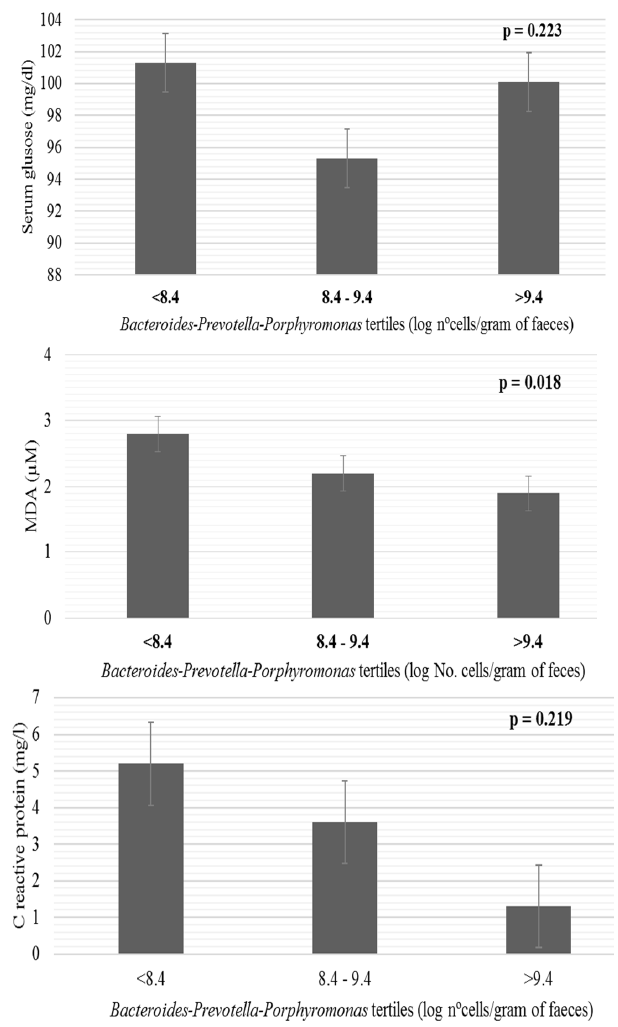
Figure 3. Differences in blood parameters related to obesity according to the levels of Bacteroides-Prevotella-Porphyromonas tertiles (log nº cells/gram of feces). Bars represent mean and whiskers standard error derived from univariate analysis adjusted by energy. MDA, malondialdehyde.